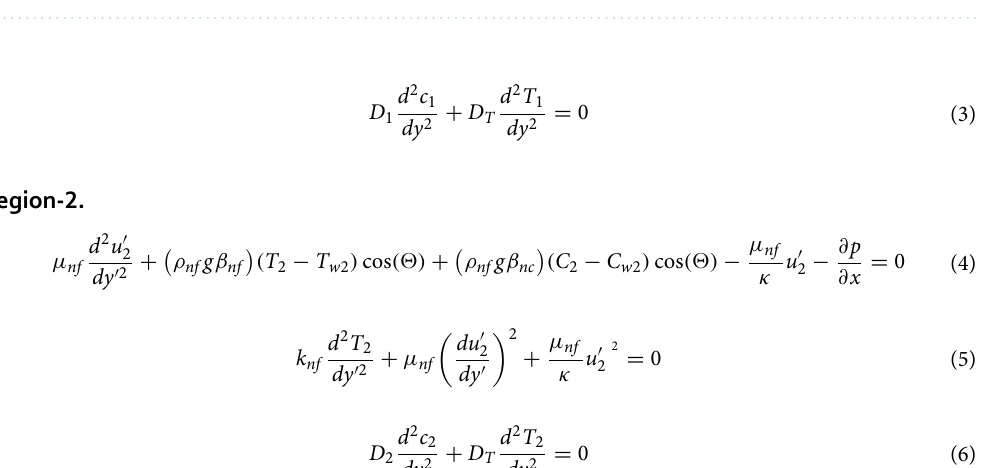
Table 1. Values of the nanoparticle’s Shape factor 47,48